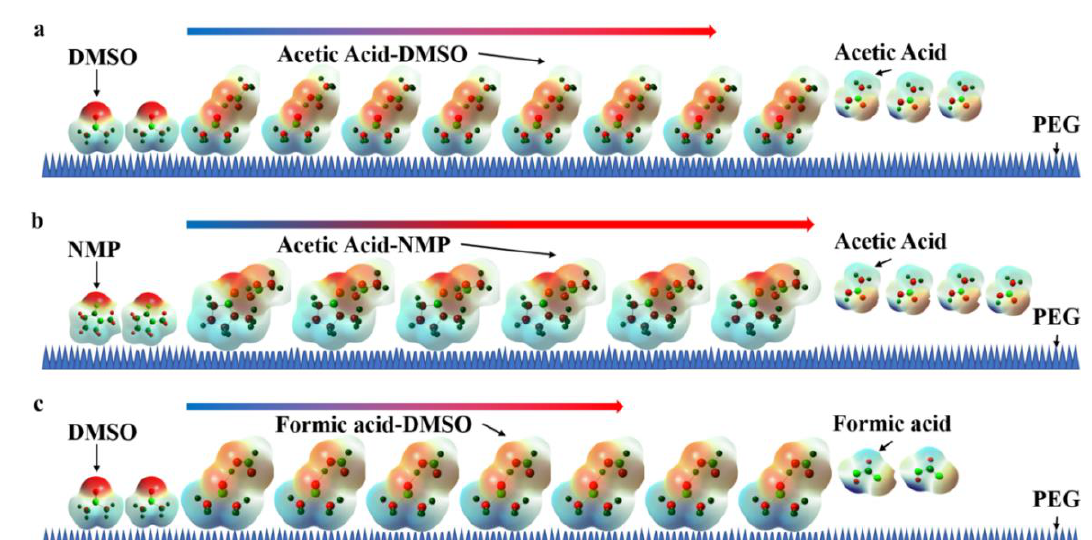
Figure 7. Effect of polar aprotic solvents on the retention time of SCFA gas chromatography and mechanism. ( a ) Effect of DMSO on the retention time of acetic acid gas chromatography and mech- anism; ( b ) effect of NMP on the retention time of acetic acid gas chromatography and mechanism; c ) effect of DMSO on the retention time of formic acid gas chromatography and mechanism.